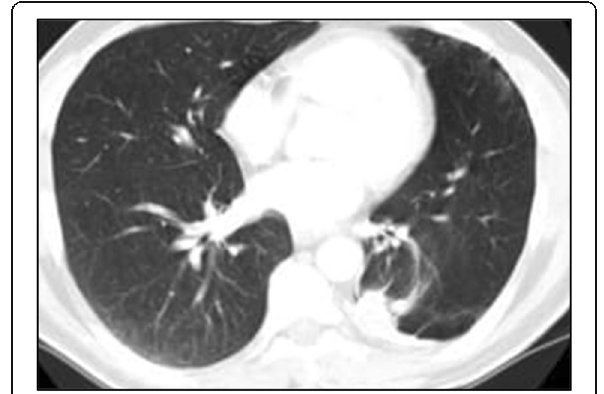
Fig. 6 A 56-year-old male smoker patient, working in plasters for 13 years, was diagnosed as having round atelectasis for 3 years with a latent period 10 years. Axial CT scan lung window showing left lower lobe subpleural soft tissue density with comet tail sign